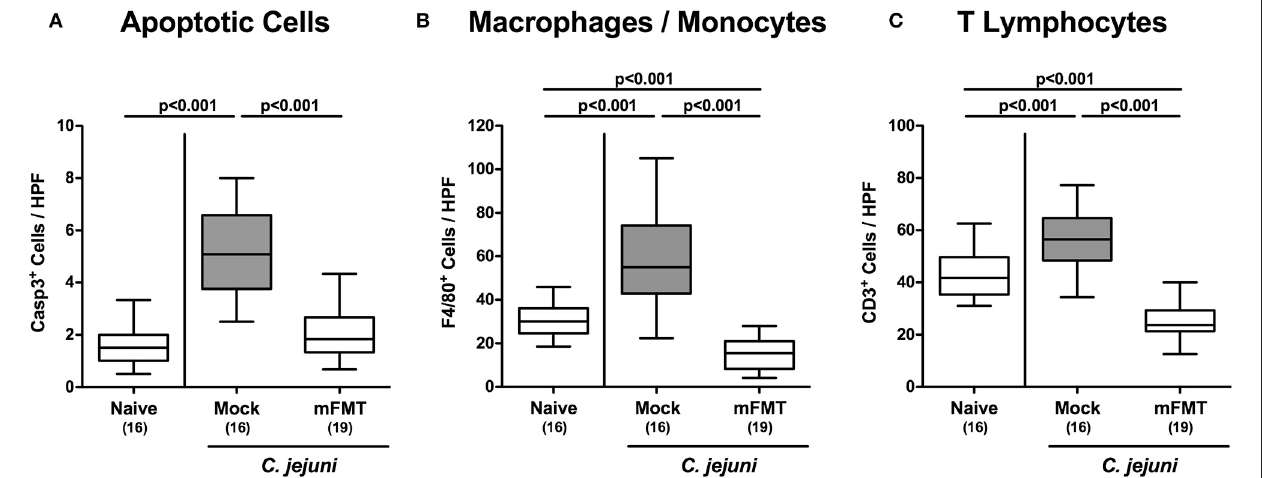
FIGURE 4 | Colonic apoptotic epithelial and immune cell responses following murine fecal microbiota transplantation of C. jejuni infected mice harboring a human gut microbiota. Mice with a human gut microbiota were perorally infected with C. jejuni on day (d) 0 and d1 and subjected to murine fecal microbiota transplantation (mFMT) on d7, d8, and d9 post-infection (p.i.) or received vehicle (mock). On day 14 p.i., the average numbers of (A) caspase3 + (Casp3 + ) apoptotic epithelial cells, (B) F4/80 + macrophages and monocytes and of (C) CD3 + T lymphocytes were assessed from six high power fields (HPF, 400x magnification) per mouse in